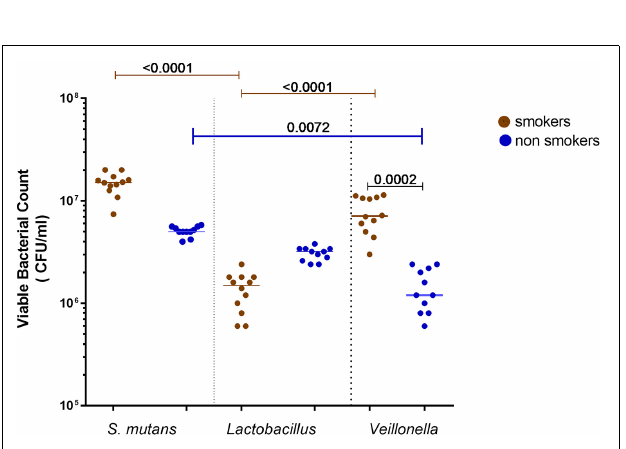
FIGURE 2 | Total viable bacterial counts of isolated identified Streptococcus mutans, Lactobacillus spp., and Veillonella spp. from oral rinse of smokers ( n = 12) and non- smokers ( n = 11). Statistical differences calculated using Kruskal-Wallis followed by multiple comparisons using Dunn’s corrections. Data presented as median ± interquartile range, where p < 0.05 was considered to be statistically significant.